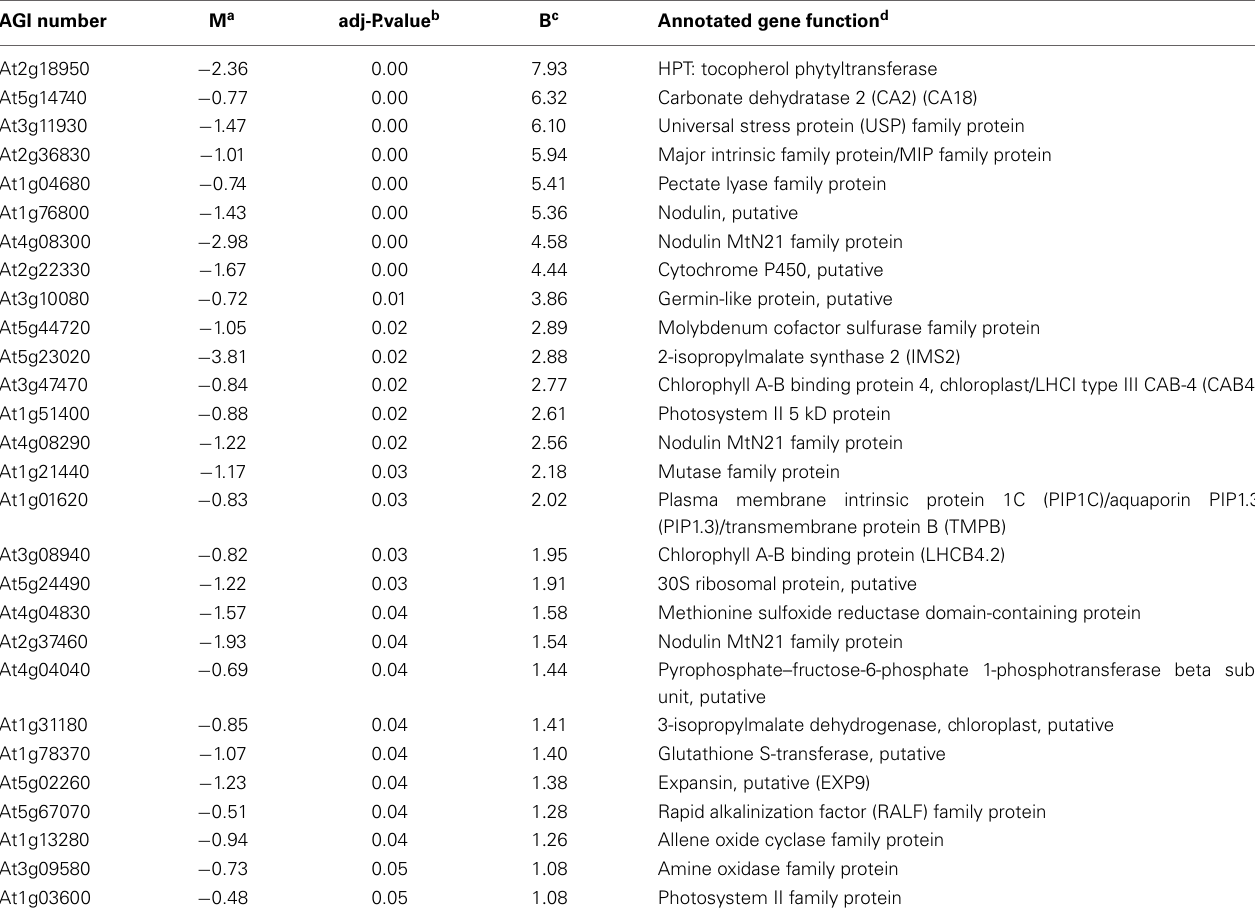
a M-value (M) is the value of the contrast and represents a log 2 fold change between 48 h-LT-treated vte2 and Col. b adj-P.value is the p-value adjusted for multiple testing with Benjamini and Hochberg’s method to control the false discovery rate. c B-statistic (B) is the log-odds that the gene is differentially expressed. d Annotation was obtained from the Gene Ontology of The Arabidopsis Information Resources.